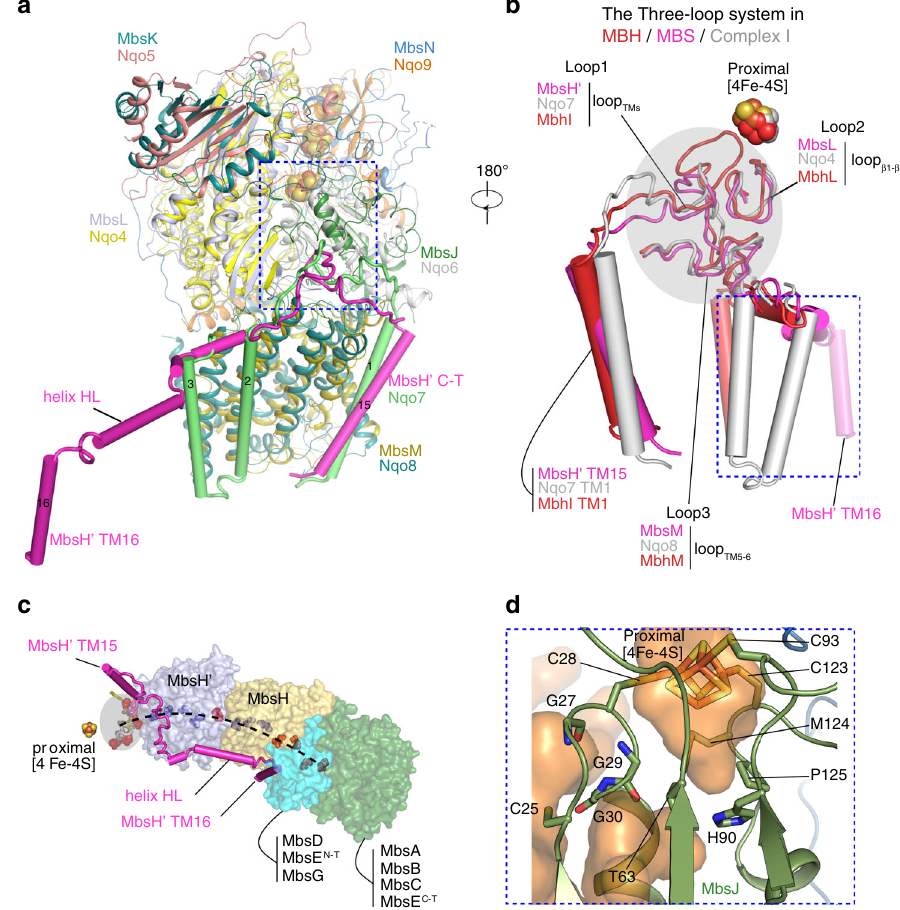
Fig. 6 Membrane-anchored peripheral module of MBS. a Superimposition of the membrane-anchored peripheral modules of MBS and complex I by aligning MbsL with Nqo4. The aligned regions are shown in cartoons and colored as the text labels. Structural elements that bridge the peripheral module to the H + -pumping module (complex I Nqo7 and MBS MbsH ’ TMH15-16, more details in Supplementary Fig. 4a) are shown as cylinders. b Between the peripheral arm and membrane arm are three interfacial loops, highlighted in gray shade, that are remarkably similar in MBH (red), MBS (magenta) and complex I (gray). The three loops are Loop TMs (Loop 1), Loop β 1- β 2 (Loop 2), and Loop TM5-6 (Loop 3) and are adjacent to the proximal [4Fe-4S] cluster. The C-terminal TMs following Loop 1 (boxed in the dashed blue square) are least similar among the three-loop systems of MBH, MBS, and complex I. c The three-loop system (gray shade) is linked to the membrane ion translocation module in the semi-transparent surface through the C-terminal TMs following Loop 1. The dashed curve marks the central charge axis, a chain of red (negatively charged residues) and blue spheres (positively charged residues) spanning across the membrane arms. d Zoomed view of the area boxed with dashed blue square in ( a ) showing the coordination of the proximal [4Fe-4S]. MbsJ residues C28, C93 and C123 coordinate three irons of proximal [4Fe-4S] cluster, but MbsJ C25 is too far to coordinate the remaining iron. The semi- transparent orange surfaces show potential solvent-accessible chambers around the proximal